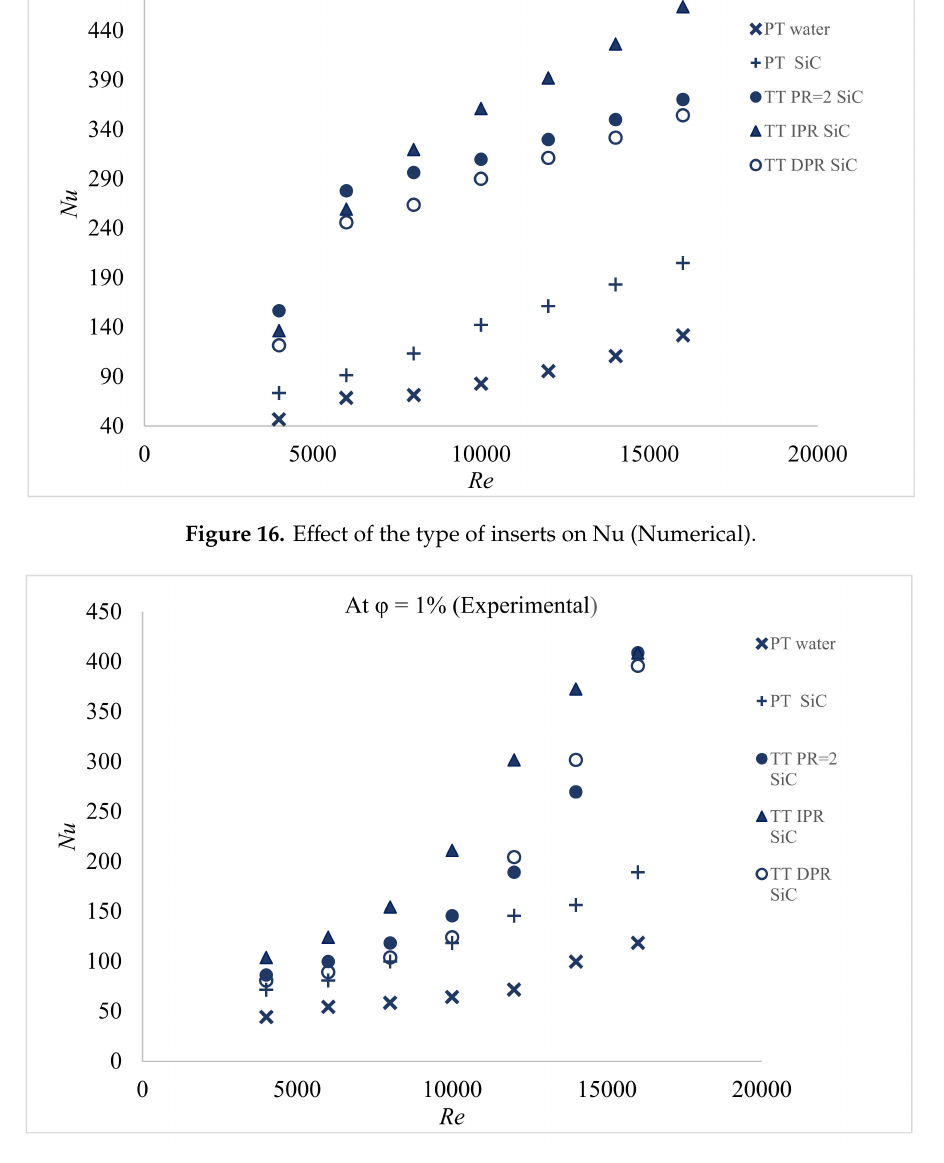
Figure 17. E ff ect of the type of inserts on Nu